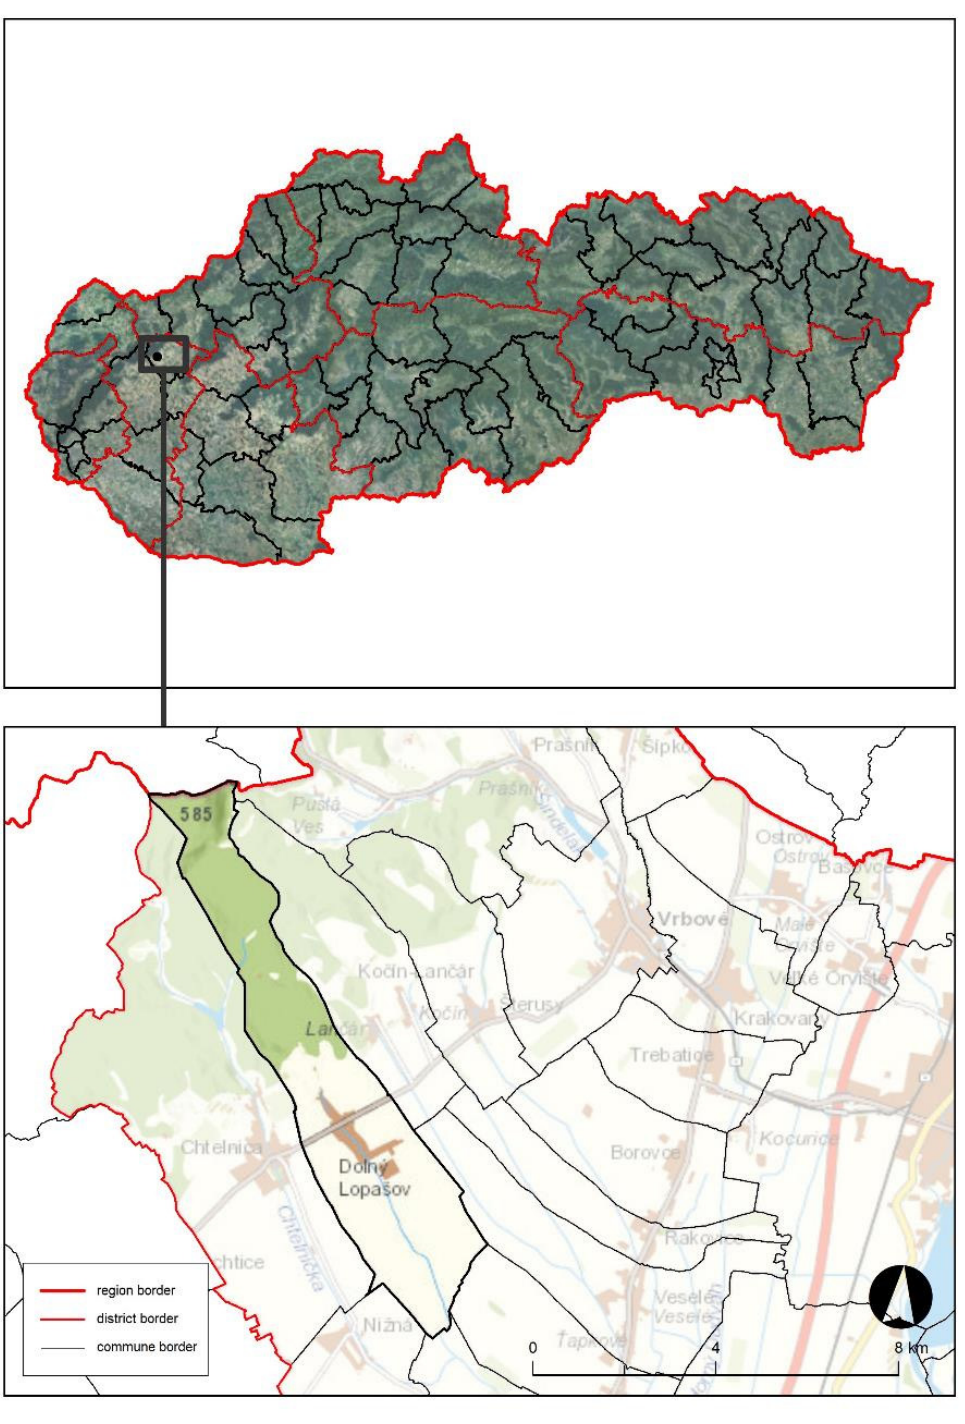
Figure 1. Doln ý Lopašov community location. Technical processing: R á kayov á , R. The current community cadastral territory is 2293.41 ha (Figures 2 and